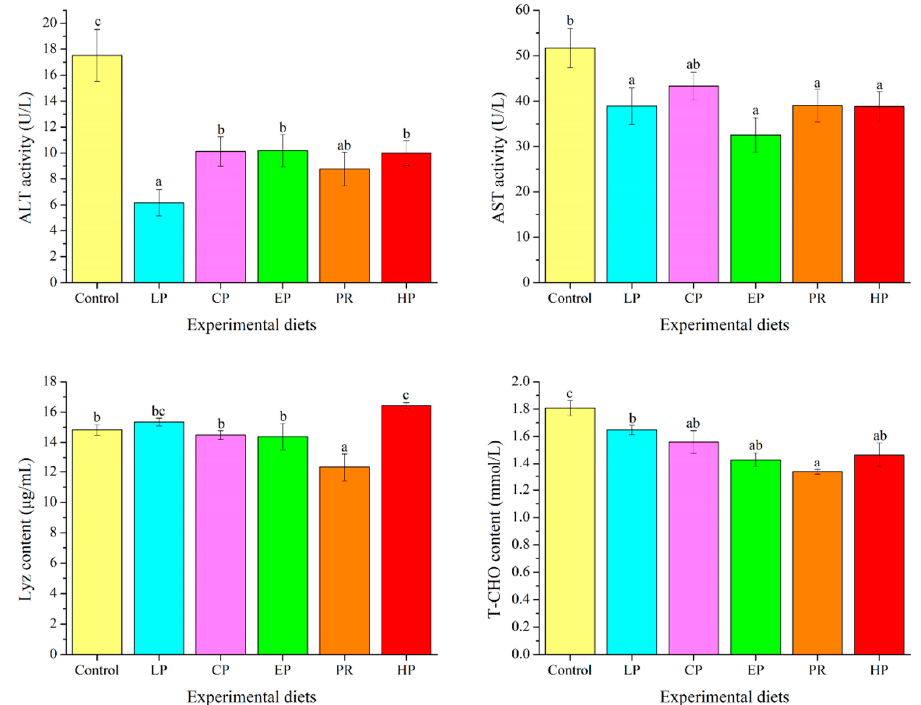
Figure 5. Effects of different diet treatments on the plasma parameters of Oncorhynchus mykiss . Values are presented as mean ± SE, n = 12. The superscript letters indicated significant differences at p < 0.05.